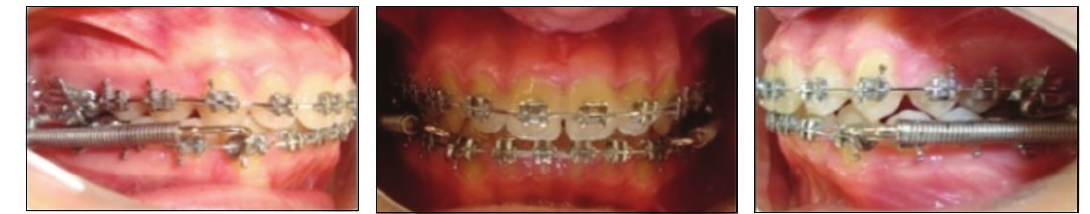
Figure 3: Progress intraoral photographs after application of the Forsus